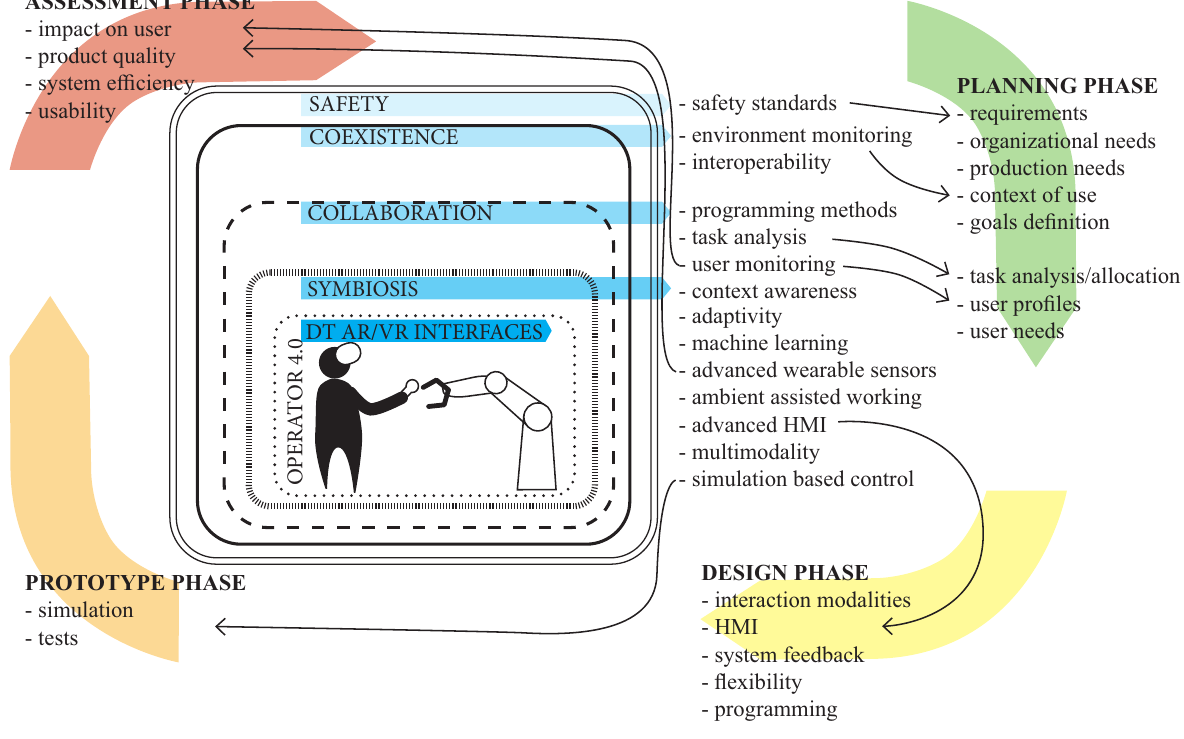
Fig. 1. Synergies between modern HRC systems and a user-centred iterative design process.